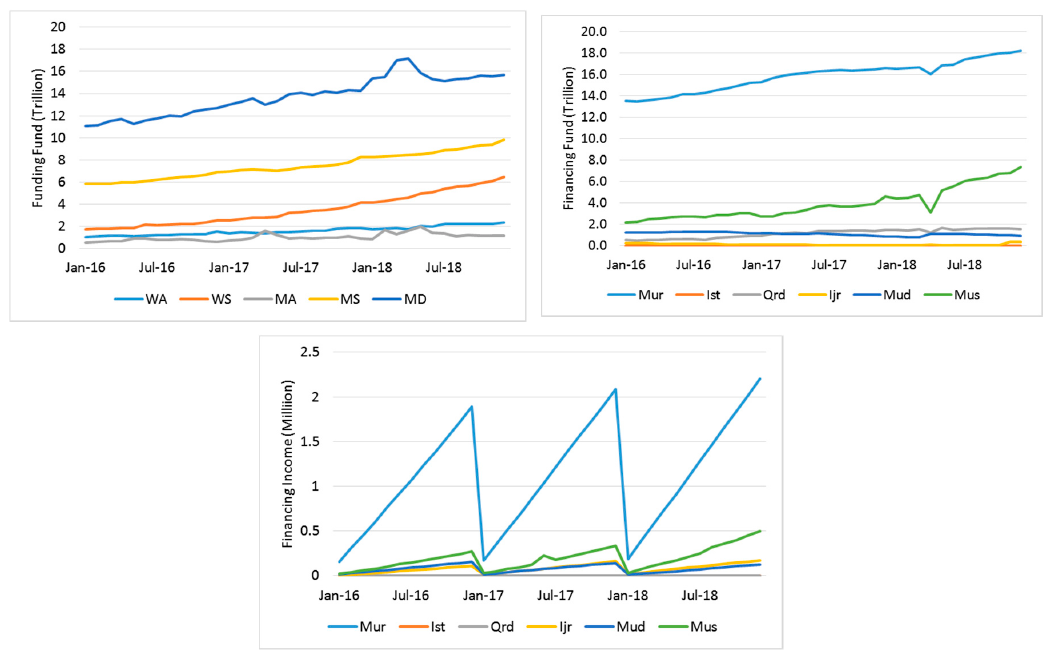
Figure 1. Funding ( top left ) and Financing ( top right ) funds; Financing income ( bottom ) from Bank C.